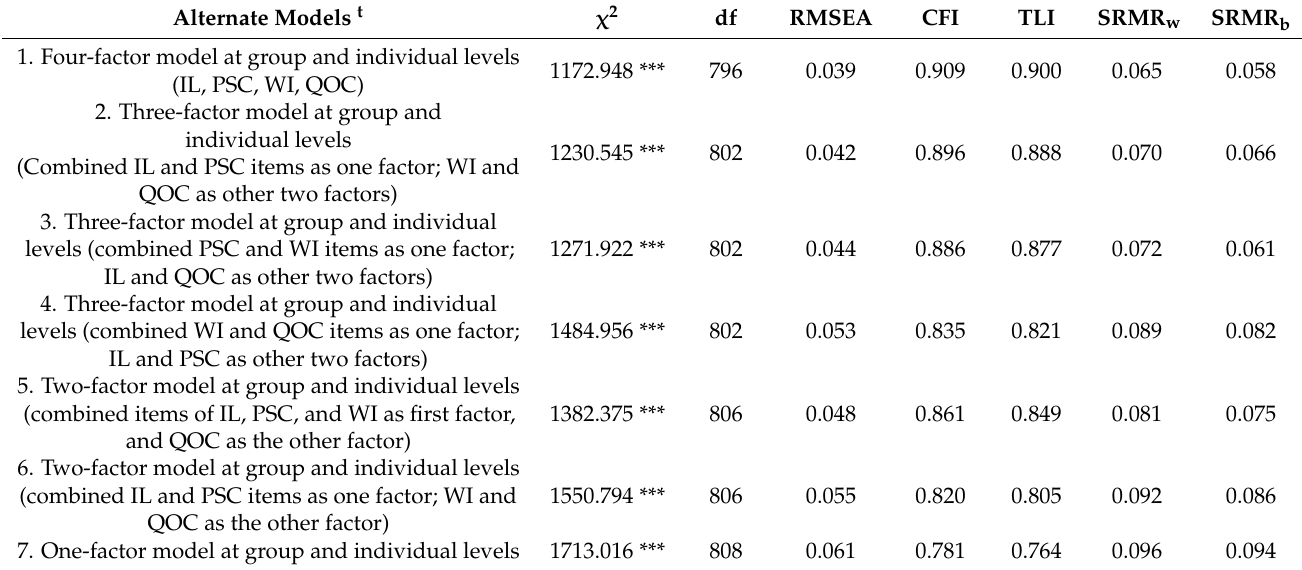
Table 1. Alternate two-level measurement